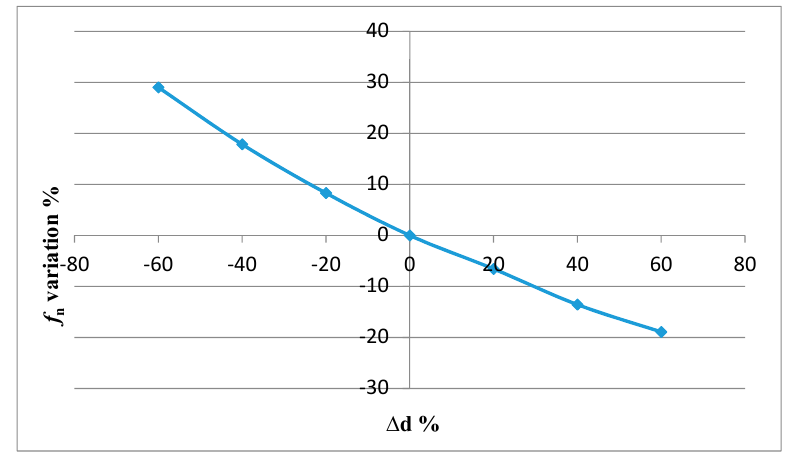
Figure 16. Sensitivity of diameter reduction vs. f 0 .